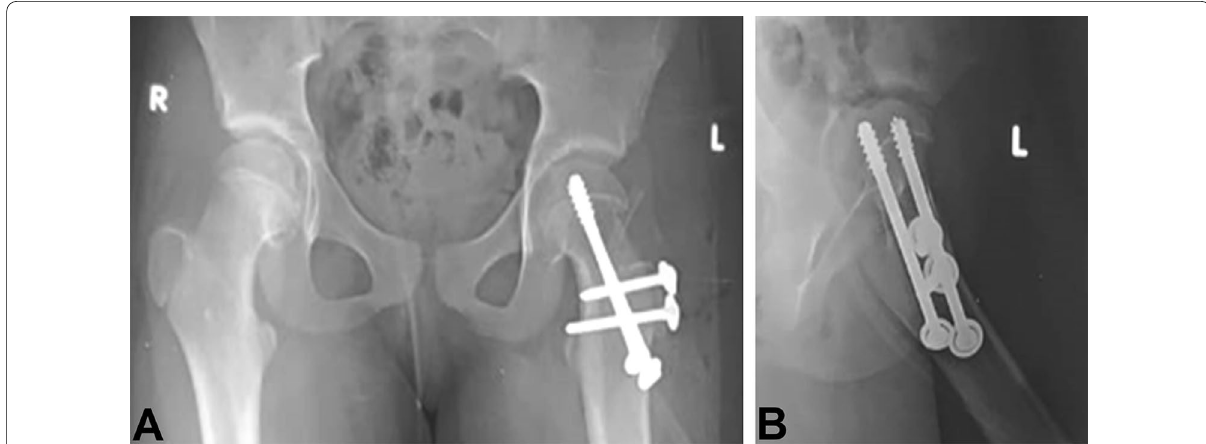
Fig. 6 Immediately postoperative X‑rays. A AP view. B Lateral